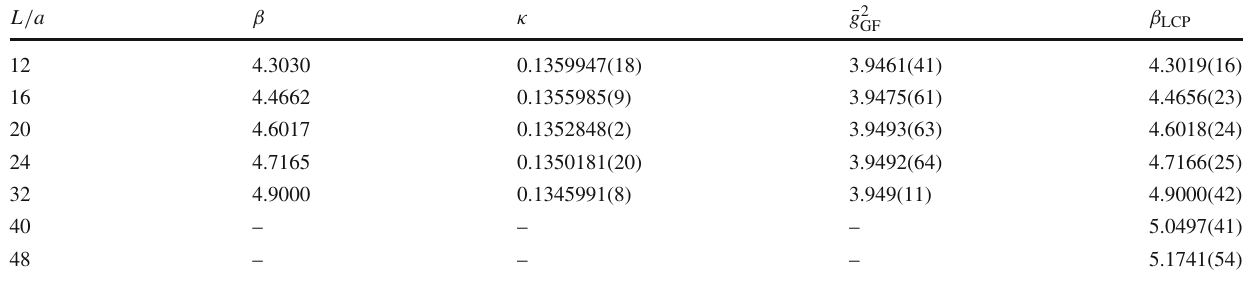
Table 1 Massless line of constant physics. The simulations described row ( L / a = 48) is obtained indirectly from our knowledge of the non- in the first four columns are taken from [36]. They are used to fix β LCP perturbativerunningofthecoupling,whilethepreviousone( L / a = 40) (μ) = 3 . 949. The last such that the renormalized massless coupling ¯ g 2 is an interpolation of the other data, see Appendix G for more GF